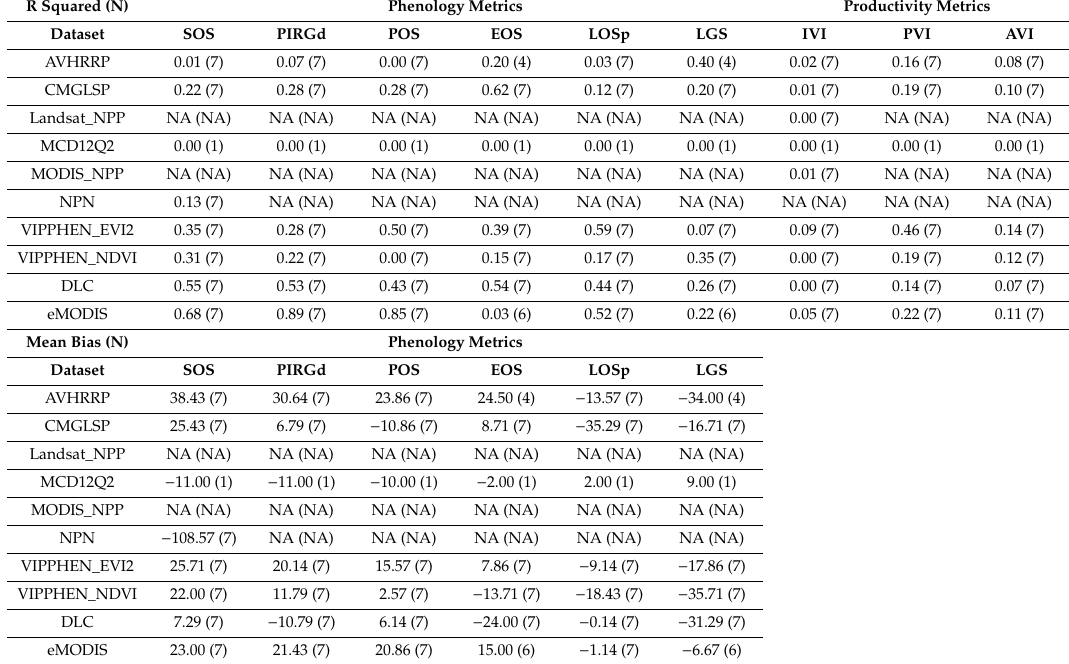
Table A4. Shrublands (SH)